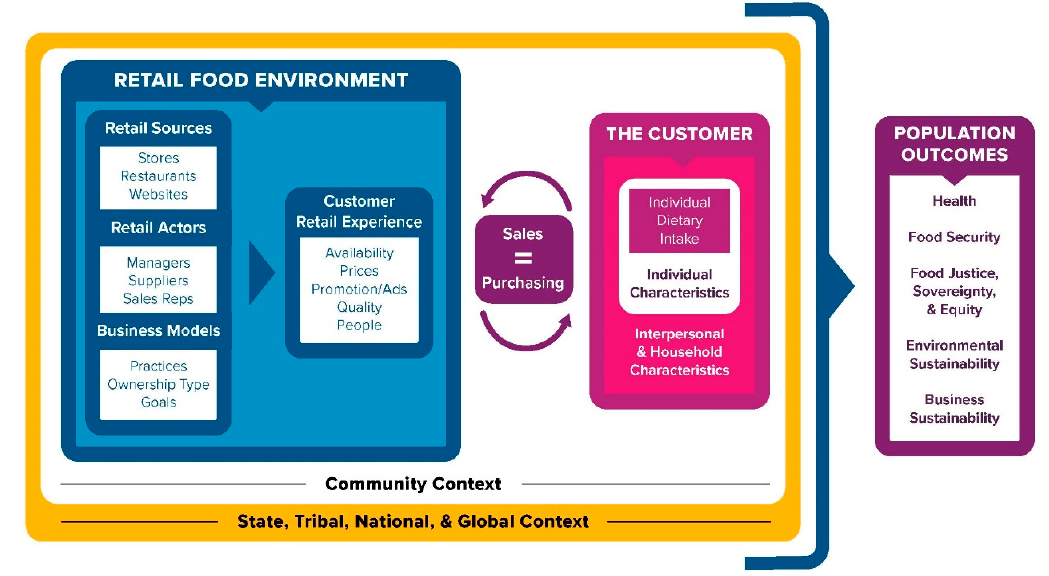
Figure 1. Retail Food Environment and Customer Interaction Model. The retail food environment consists of retail sources, retail actors, and business models that influence the customer retail experience. Customers involve individual, interpersonal, and household characteristics that affect customer purchasing and thus the retail sales of foods and beverages. Both the retail food environment and customers and their households are embedded in macro-level contexts (e.g., communities and nations), and as a result of the interactions and dynamics among these multiple model components, a host of population outcomes are produced: health, food security, food justice, environmental sustainability, and business sustainability. Definitions for model components are provided in Table 1. Table 1. Definitions for key model